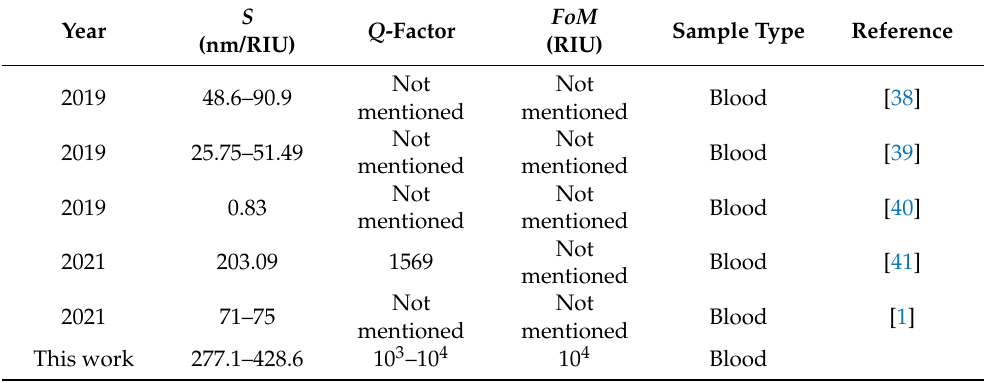
Figure 8. The sensitivity of the proposed design having a cavity thickness of d D = 700 nm as a function of the refractive index of normal and infected blood samples containing different components. Table 3. Performance evaluation table showing the comparison between the results of the present work and the previous work of a similar type for the proposed photonic structure (PQ) N/2 D(PQ) N/2